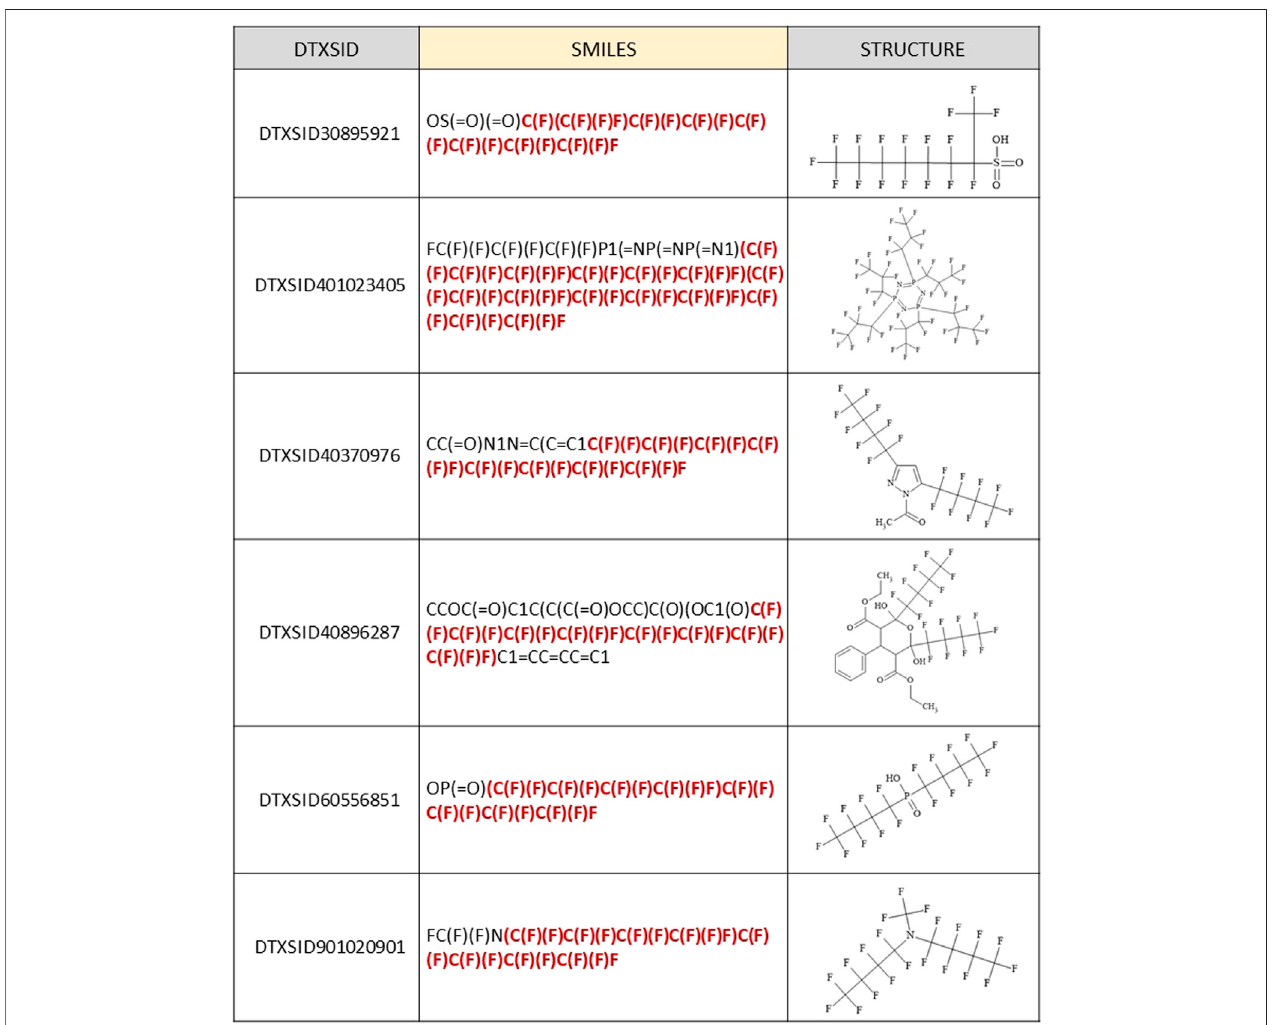
FIGURE5| ExamplesofJChem SMILESandcorrespondingstructuresthatwerefalselypredictedtofallwithintheSCPFOAlisting (5outof35totalshown)dueto contiguous representation of multiple per fl uoro chains shorter than C7F15, with the portion of the SMILES that was misinterpreted highlighted in red.